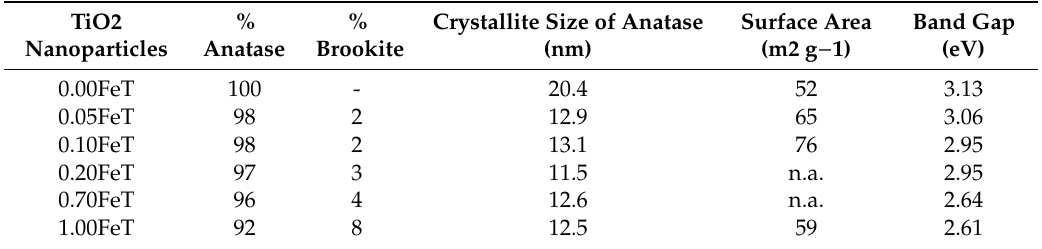
Table 2. Structural data, and textural and optical parameters of Fe-doped TiO 2 nanoparticles. TiO2